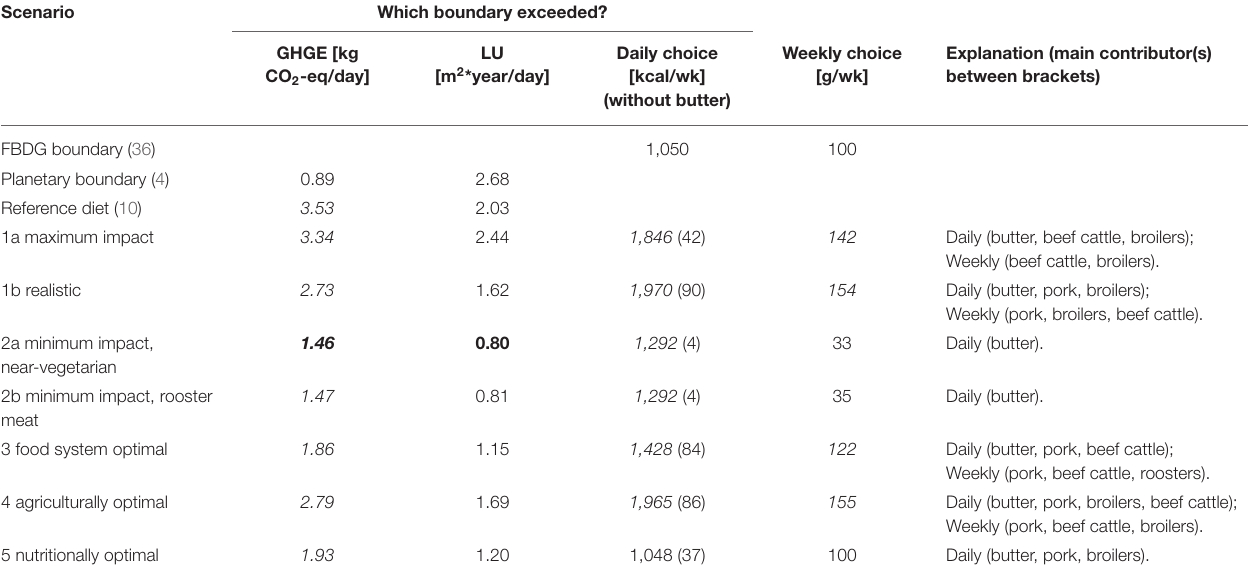
TABLE 5 | Overview of maximum nutrient intake recommendations exceeded (in italic) in the different scenarios. Scenario Which boundary exceeded?